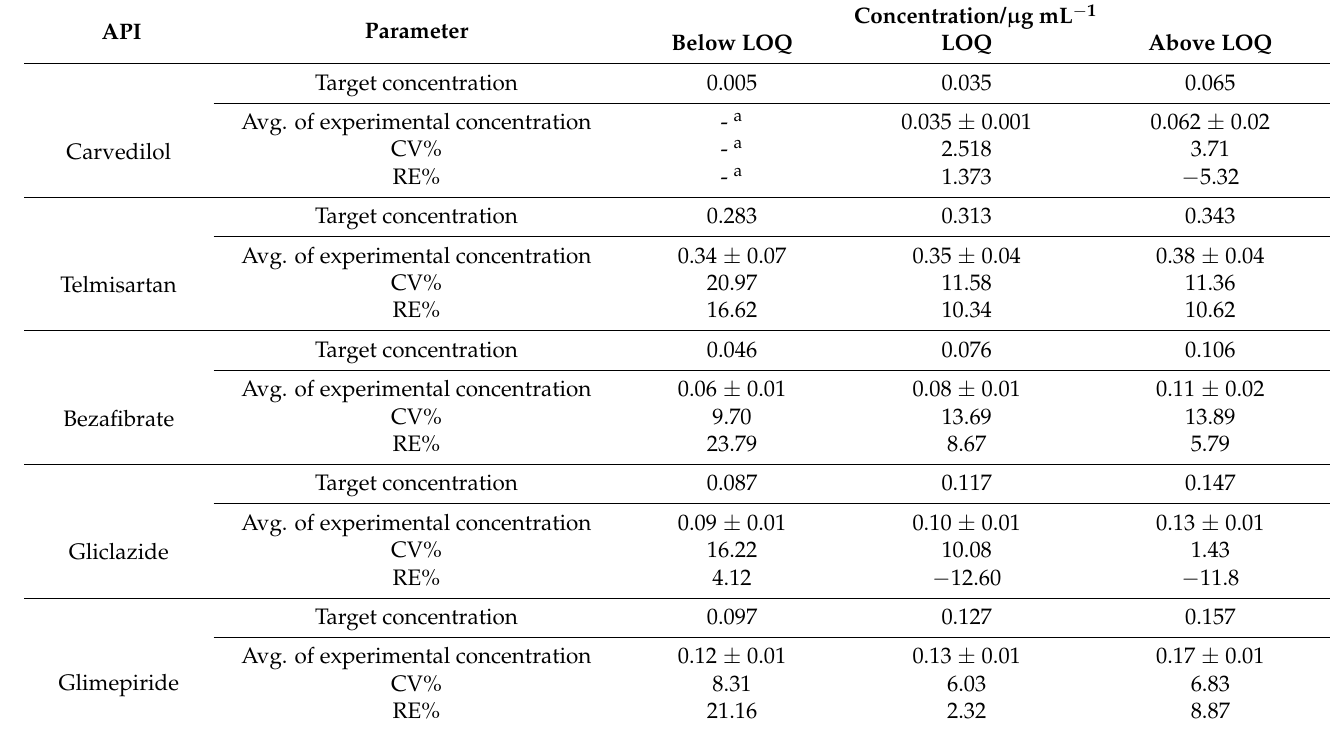
Table 2. Validation of limit of quantification (LOQ) of active pharmaceutical ingredients (API) with concentration at, below and above